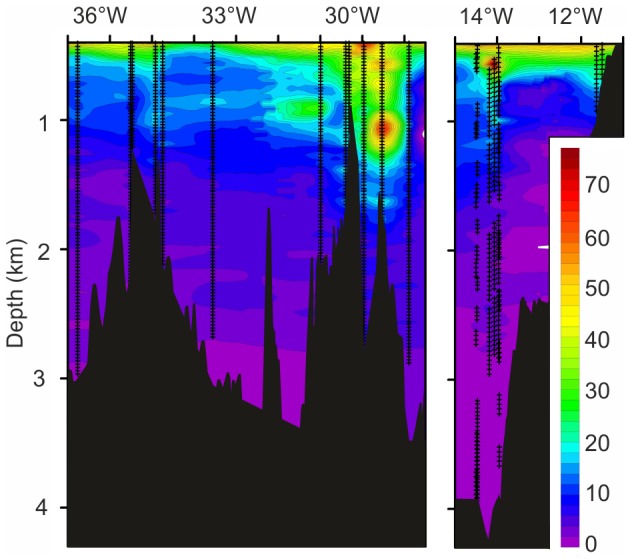
Vertical distribution of bioluminescent organisms.Abundance of organisms (number.m−3) between the MAR and the Porcupine Seabight from profiles at the triangle symbols in Figure 4. Black area is the sea floor.